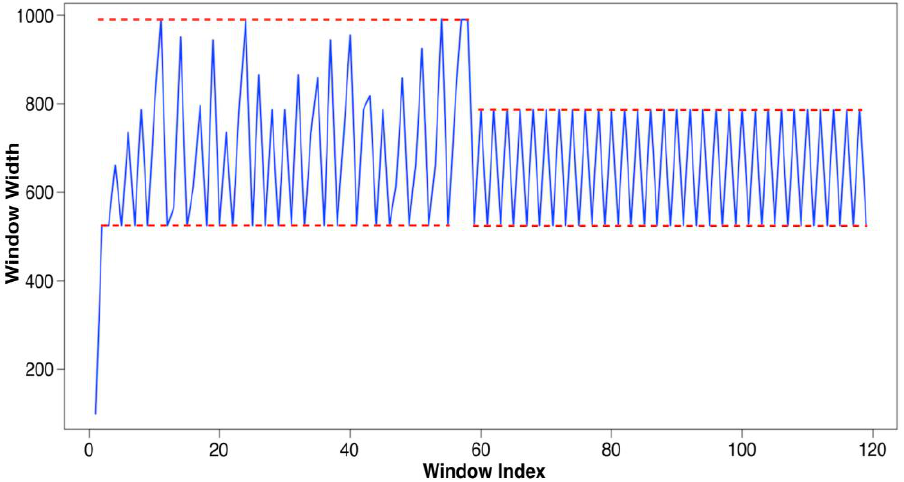
Figure 14. DW trajectory. Figure 14. DW